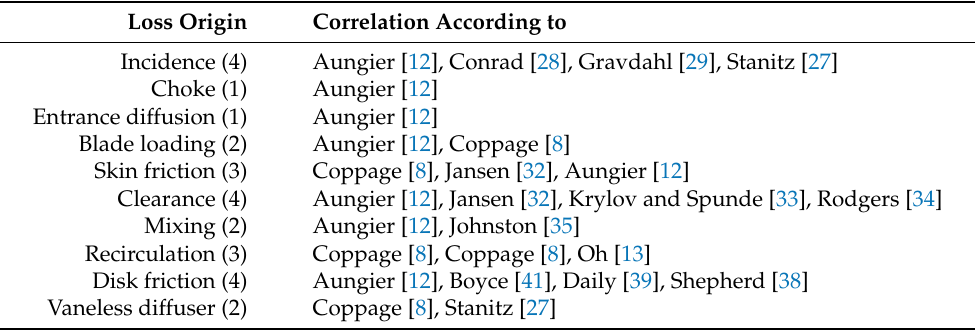
Table 2. Individual loss model correlations from Section 3 sorted according to physical origin of the loss. This gives 4608 possible combinations of different loss model